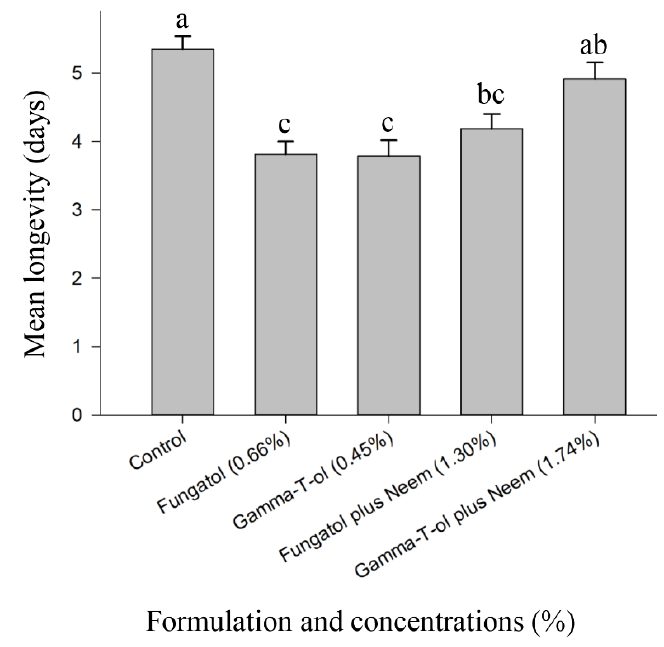
Figure 4. Effect of concentrations of Fungatol, Gamma-T-ol, Fungatol plus neem, and Gamma-T-ol plus neem on adult A. colemani longevity when exposed to formulation residues on glass plates in the laboratory. Each formulation was applied at a concentration resulting in 90% mortality of cotton aphids. One-way ANOVA with the Duncan multiple comparisons test revealed significant differences between the treatments. Different lowercase letters above bars represent significant differences at p < 0.05. Data presented are mean ± SEM.